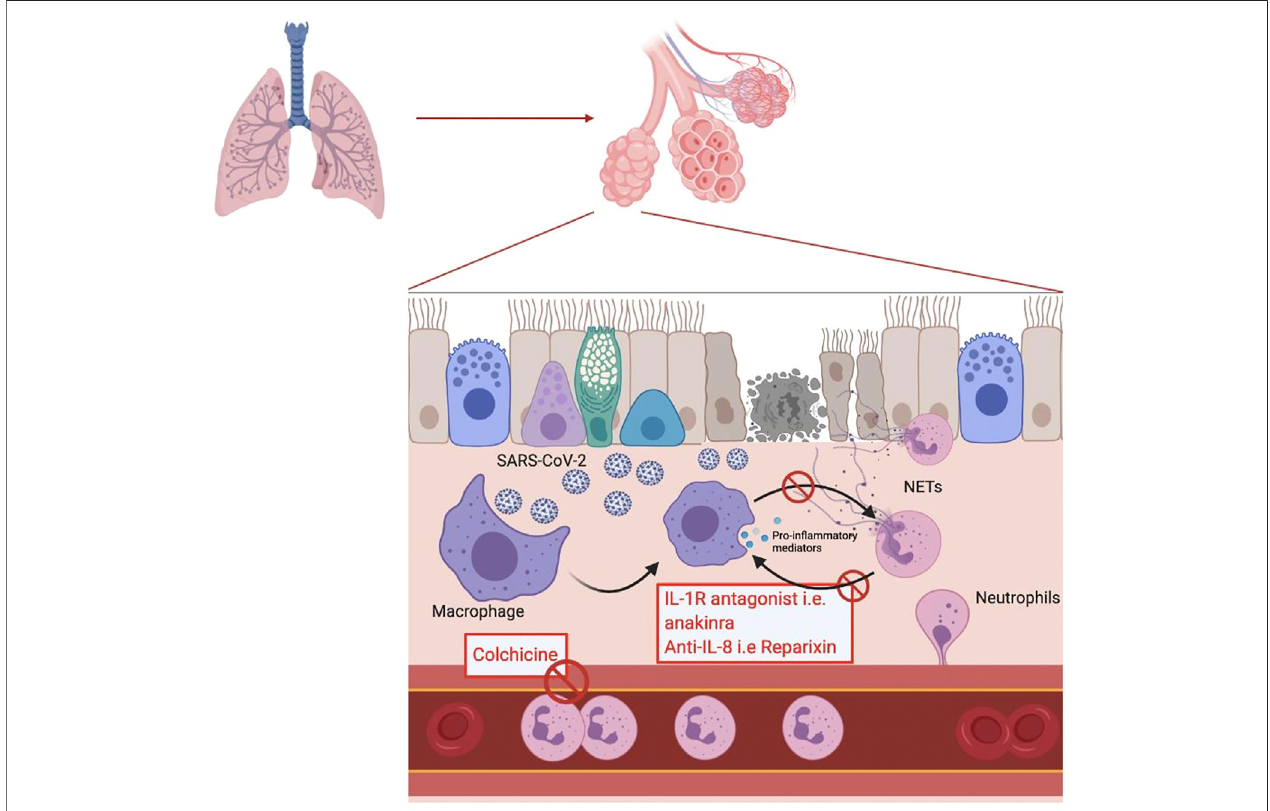
FIGURE 1 | Schematic representation of the in fl ammatory response to a SARS-CoV-2 viral infection in the alveolar endothelium. In the red box are mentioned the potential treatments acting by inhibiting the mechanisms involved in the response.